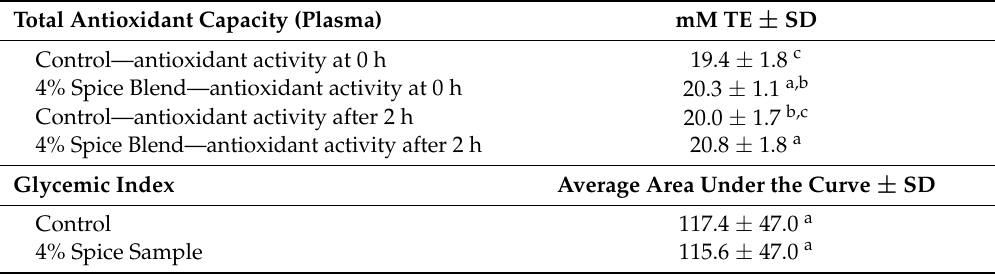
Table 3. Results from the clinical study ( n = 10).